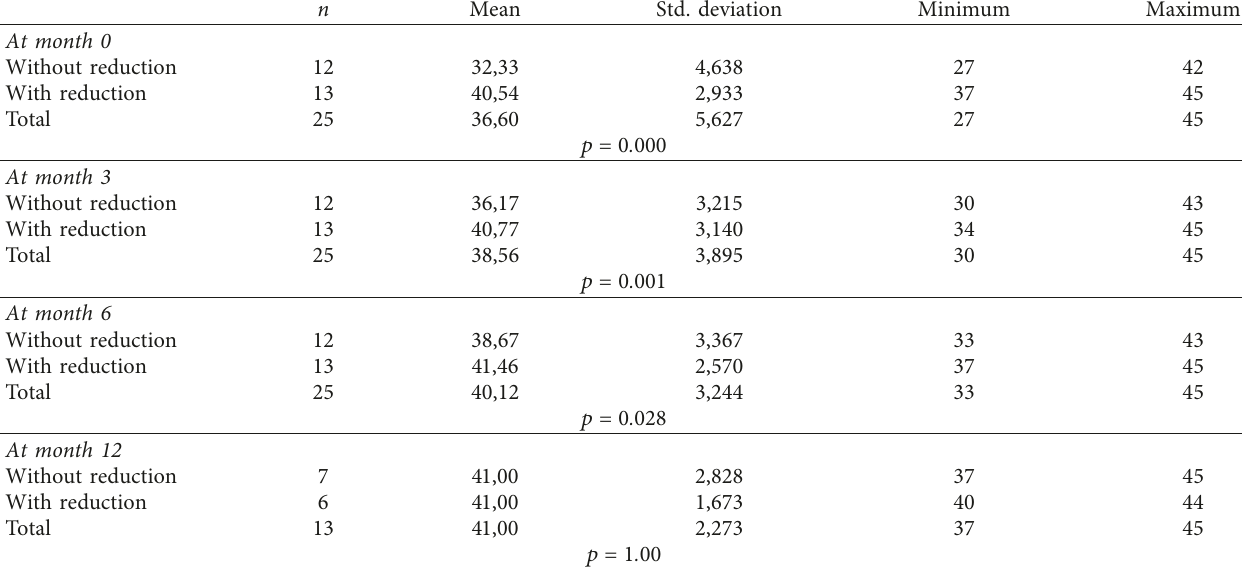
Table 4: Statistic calculation of the patient’s variable “distribution of patients’ maximal interincisal opening with respect to diagnosis” during the treatment period. n Mean Std. deviation Minimum